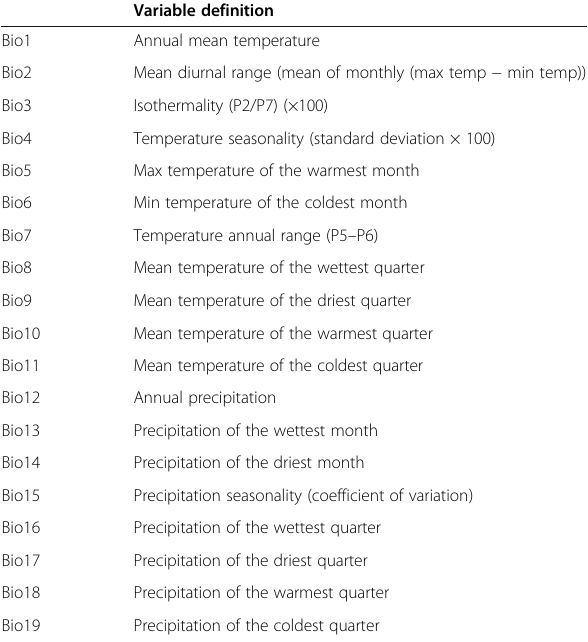
Table 2 Definitions of the climatic variable